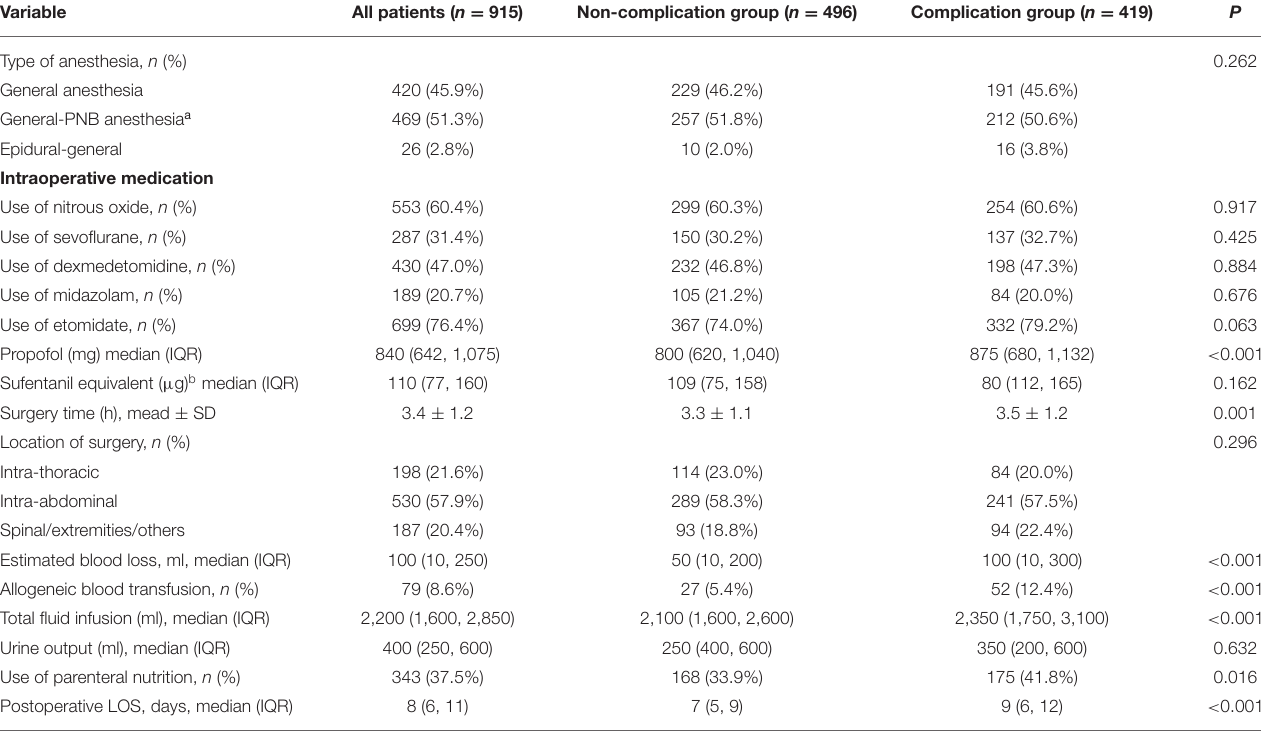
TABLE 3 | Perioperative variables.